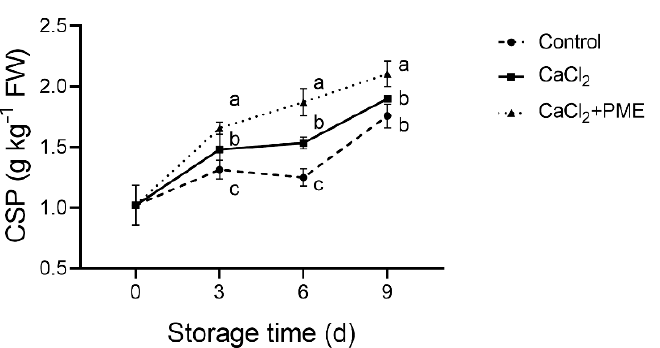
Figure 4. Effects of different treatments on CSP content of raspberry fruit. Data presented were based on three replicates. Vertical bars represent standard deviations of the means. Different lowercase letters indicate the significant differences among treatments ( p < 0.05).